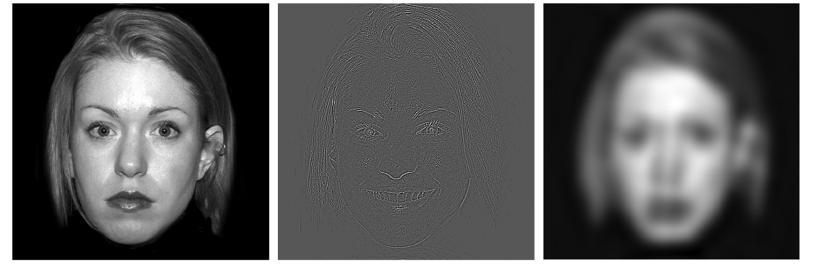
Fig. 1. Examples of BSF (left), HSF (center), & LSF (right) stimuli from gender discrimination